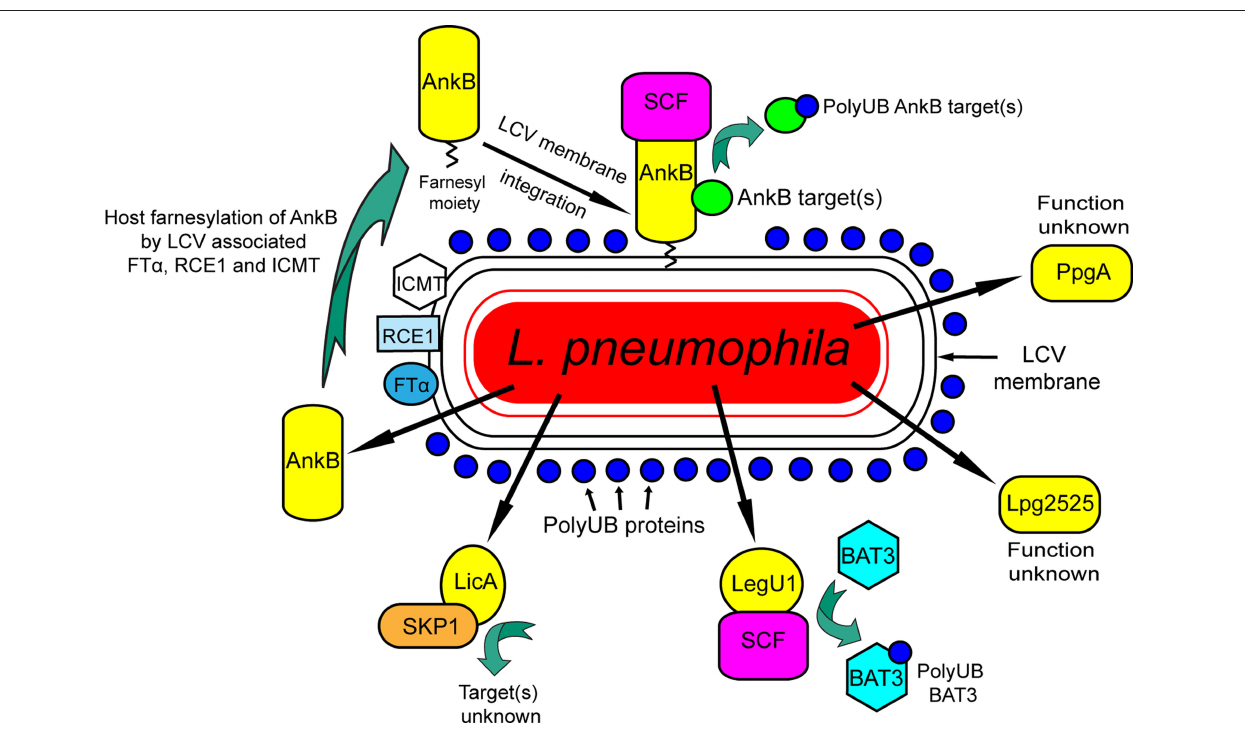
FiGure 2 | The F-box proteins of Legionella pneumophila . Five F-box proteins of L. pneumophila are translocated into the host cell. Two of these, PpgA and Lpg2525 do not interact with host SKP1 and their function is unknown. LicA interacts with SKP1 but its function is unknown. LegU1 interacts with the SCF complex to